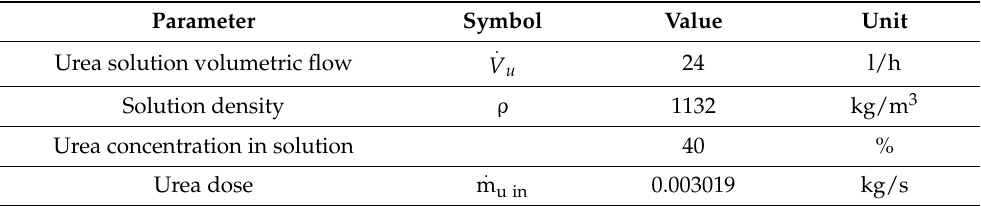
Table 4. Parameters of incoming urea solution stream.